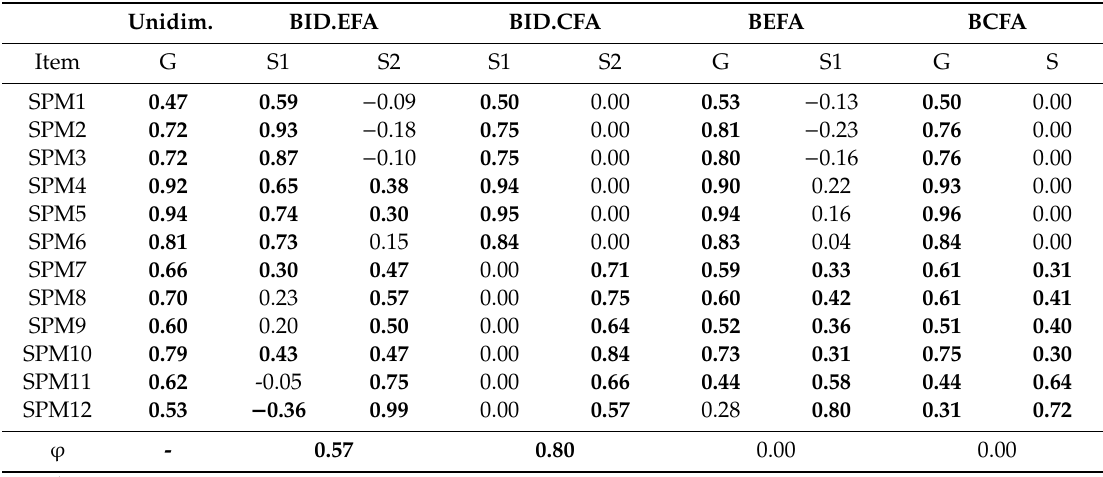
Table A4. Standardised factor loadings for all model